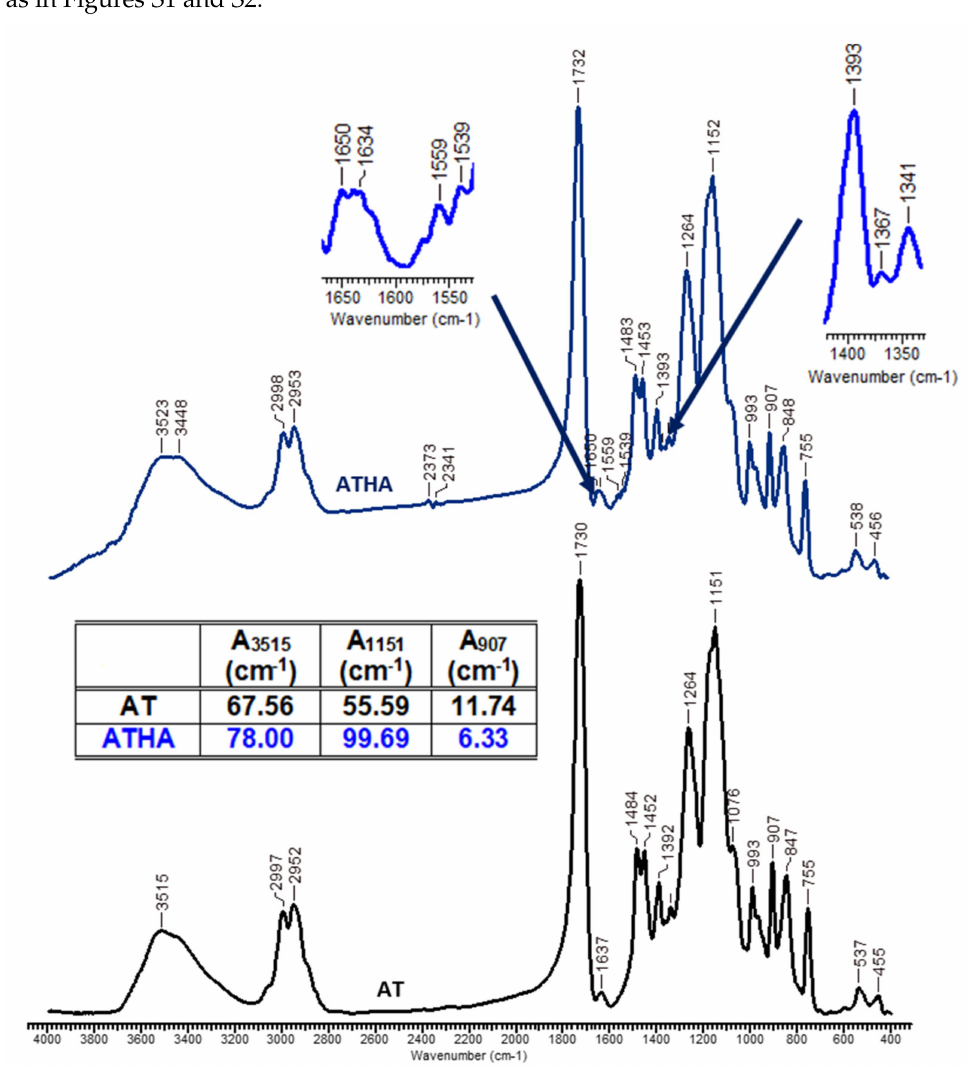
Figure 5. The infrared spectra of AT and ATHA microparticles. The characteristic absorption bands of AE, AD and AT microparticles are located at: 3452, 3482 and 3515 cm − 1 , characteristic of valence vibrations ν O-H belonging to the HEMA monomer; 2991–2997 cm − 1 and 2953 cm − 1 are specific to the symmetric and asymmetric stretching vibrations of the -CH 3 , >CH 2 and >CH- groups; 1633, 1634 and 1637 cm − 1 are attributed to the >C=C< bond; 1730 cm − 1 is characteristic of the >C=O bond of the ester group, which is present in all the chemical structures of the three types of precursor microparticles; 1481 and 1484 cm − 1 are specific to the bending vibration of the methylene group ( δ CH2 ); and 907 cm − 1 is attributed to the stretching vibrations of the epoxy